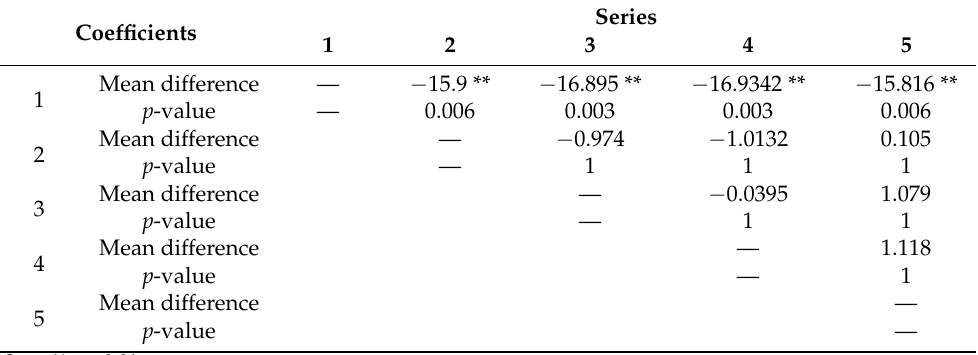
Table 6. Pearson’s correlation matrix among the different analytes for all times series. Concentration